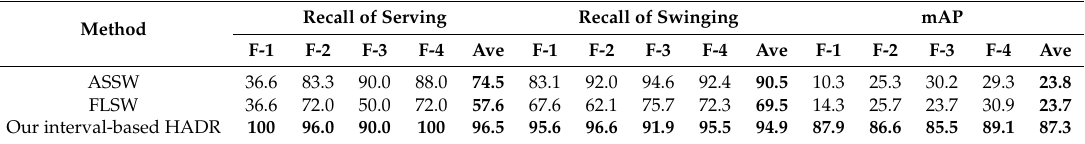
Figure 9. The duration distribution of the target motion states in badminton. Table 3. Comparison with sliding window methods. Feature extraction and a support vector machine (SVM) classifier were used for a set of sliding windows (ASSW) and a fixed-length sliding window